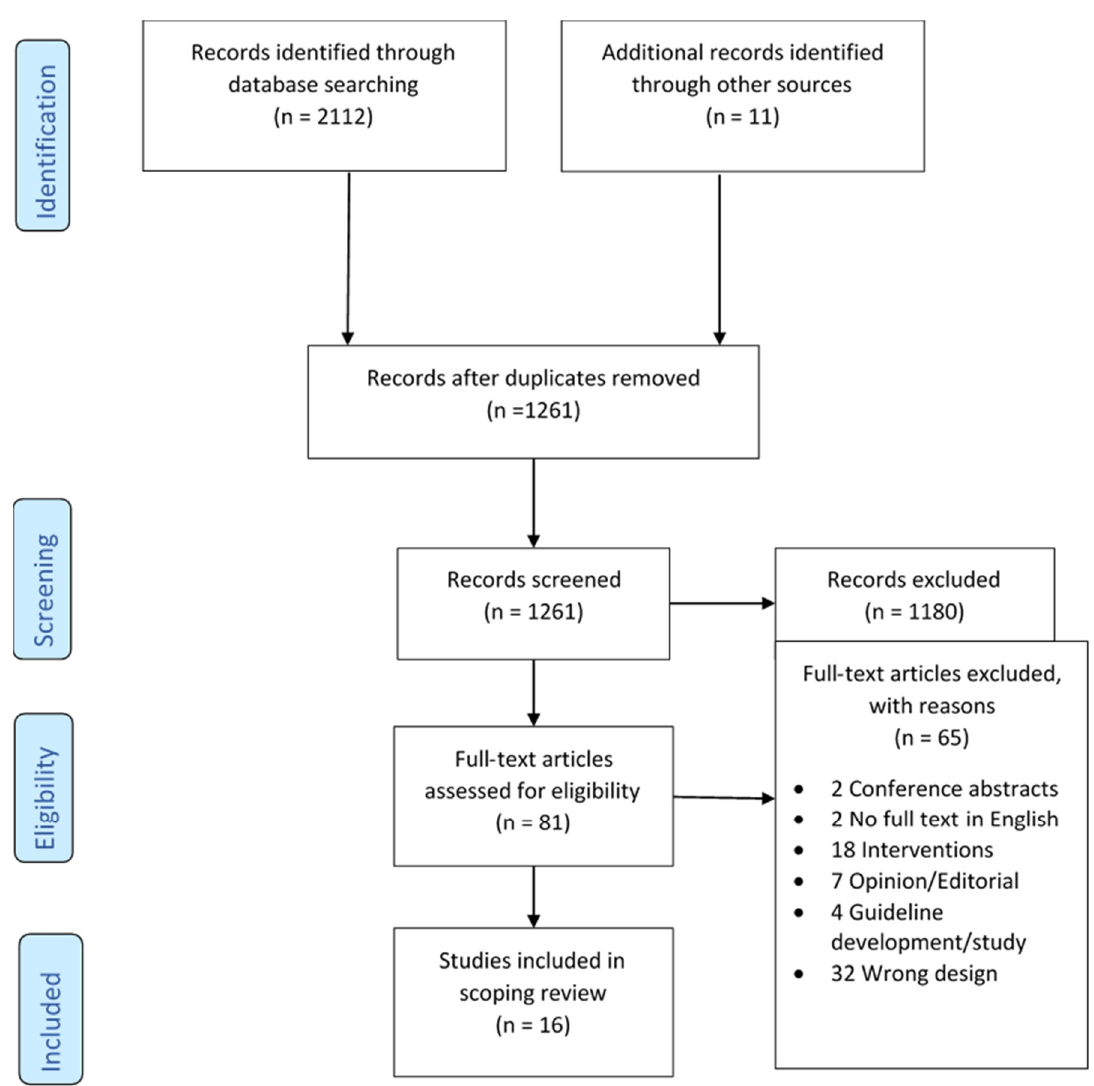
Figure 1. Preferred Reporting Items for Systematic reviews and Meta‐Analyses extension for Scoping Reviews (PRISMA‐ScR) flow diagram.